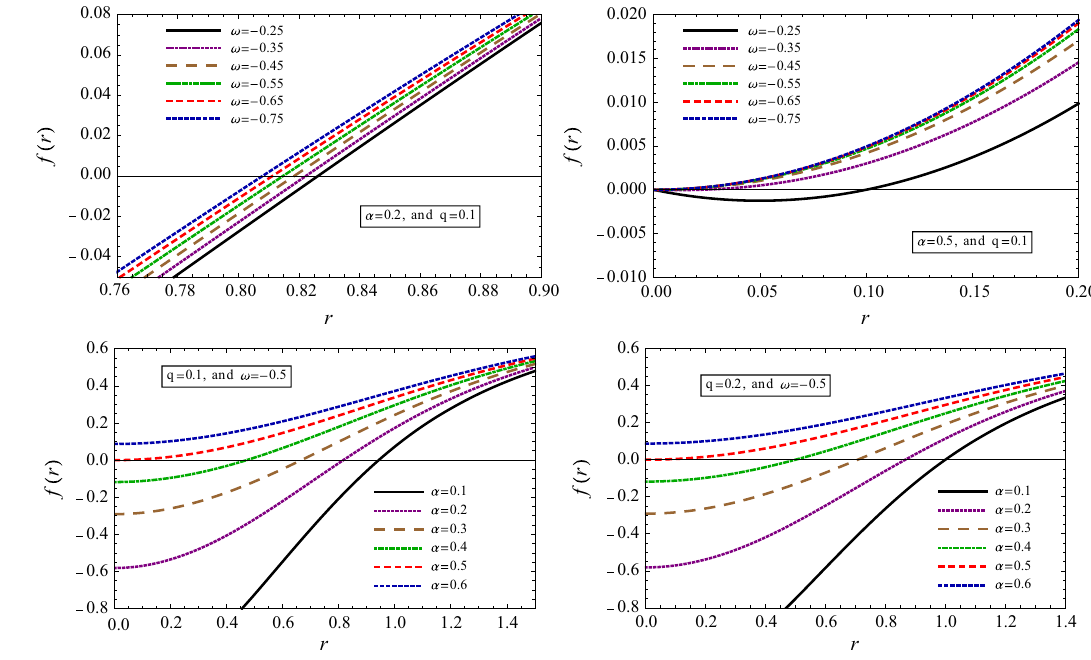
Fig. 1 Plot of metric function f ( r ) vs. r for the 5D Einstein–Gauss–Bonnet black hole surrounded by the quintessence matter